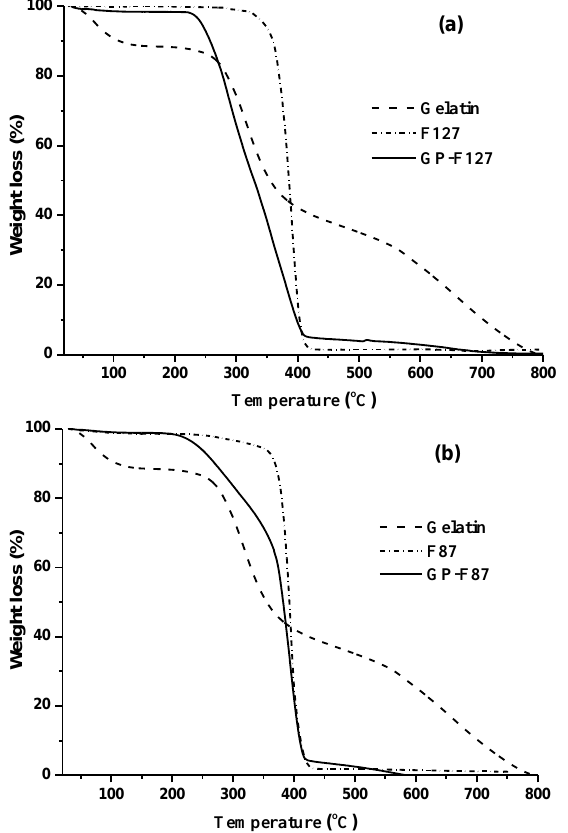
Figure 3. TGA thermogram of gelatin, pluronic F127 ( a ), pluronic F87 ( b ) and its grafted gelatin. Table 1. Polymer composition of the grafted copolymers from TGA curves. Sample